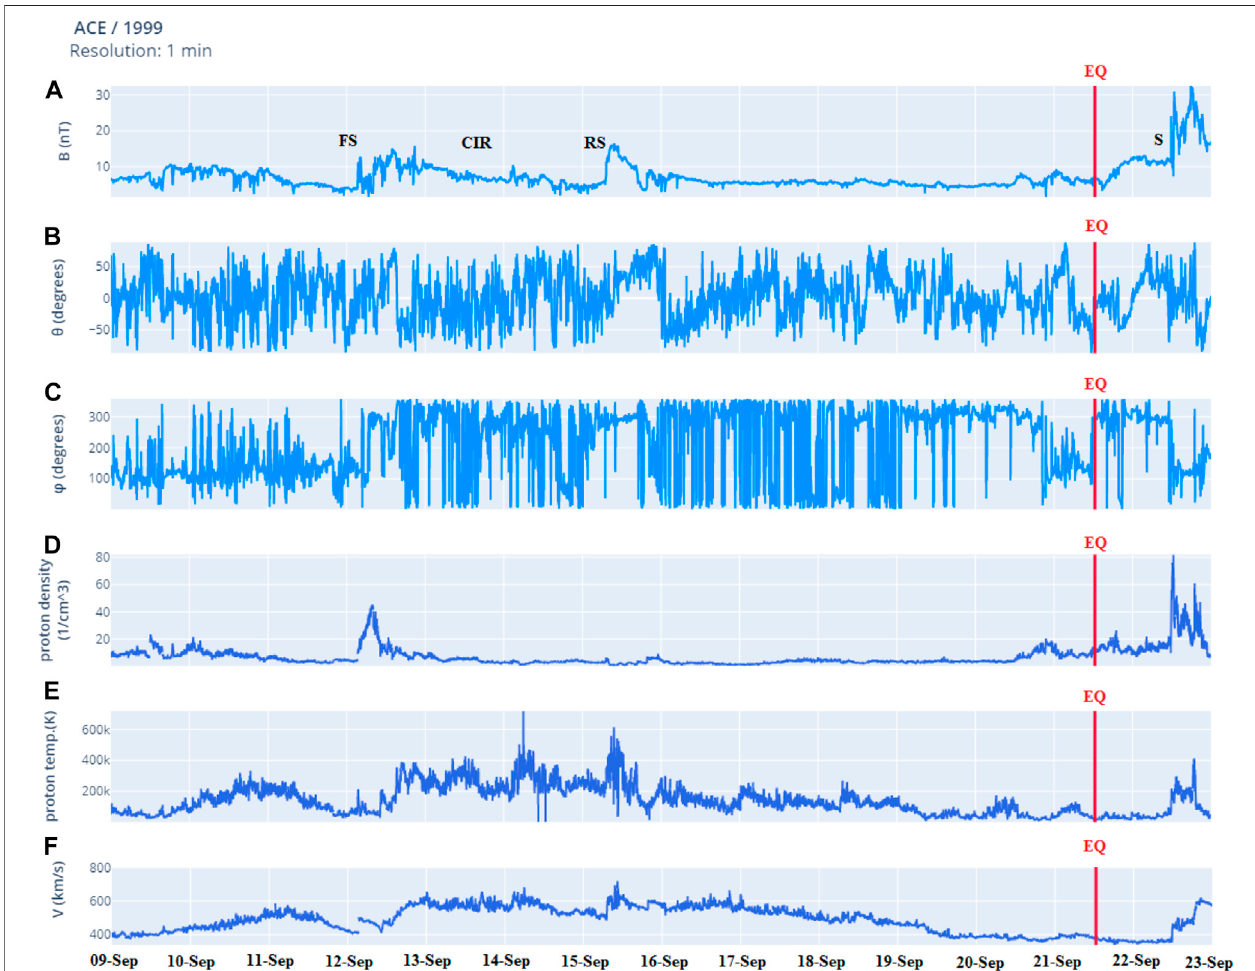
FIGURE 4 | Magnetic fi eld data (B, θ φ ) in spherical coordinates three top panels; (A-C) , Brms, and proton plasma density, temperature and speed three bottom panels; (D-F) asrecordedbytheACEspacecraft,forthetimeintervalSeptember9 – 22,1999.TherednormallineindicatesthetimeofTaiwanearthquakeoccurrence,at the end of a corotating interaction region (CIR), which is accompanied by rich presence of ULF Alfvèn waves.